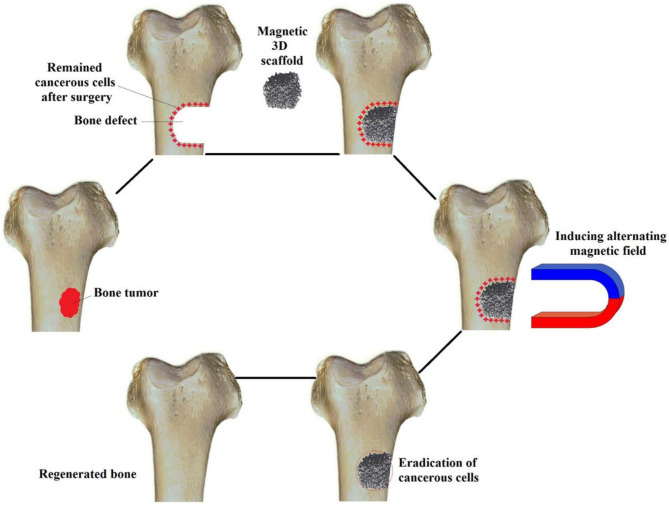
Schematic for applying a Mg2SiO4-CoFe2O4 nanocomposite scaffold as a multifunctional magnetic scaffold to eradicate remaining bone cancerous tissues after surgery and regenerate the defect. Reproduced with permission from Bigham et al. (2019).